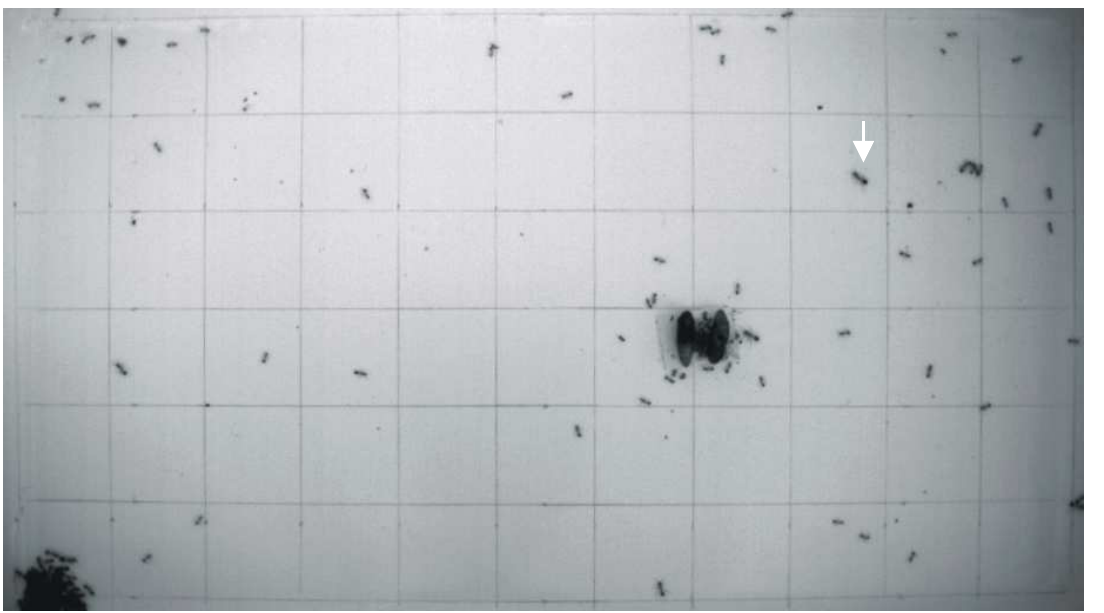
Figure 2. Sample image taken at the bottom of the test tub: fire ants, food source, dusts, grid lines, and shadows are